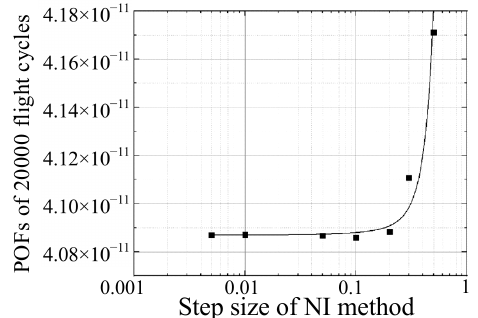
Figure 8. POFs of cases applying the NI method.